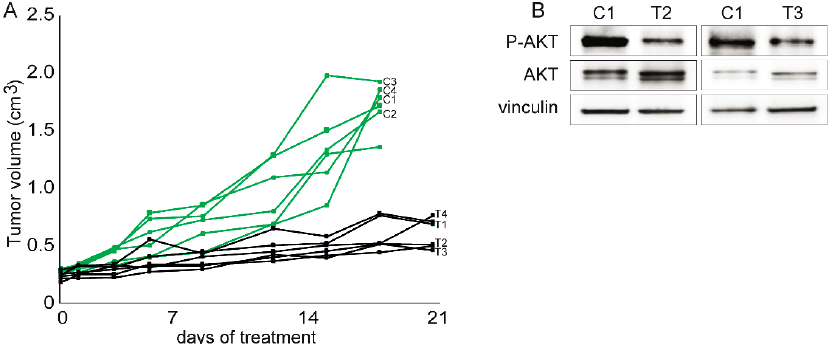
Figure 6. In vivo response of the PIK3R1 W624R PDXs to buparlisib. Randomized mice were divided into two cohorts and treated with 20 mg / kg buparlisib, administered as described in the Methods section. ( A ) Growth curves of treated (black solid lines) and control (green solid lines) animals. ( B ) Western blot analysis of the phosphorylation of the AKT signal transducer in response to drugs, as a proxy of PI3K activation status in response to drugs, in the individual treated (T2 and T3) and control (C1) PDXs indicated in panel (A).